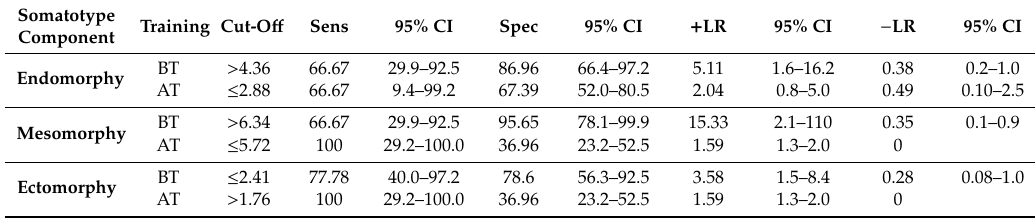
Table 5. Sensitivity. specificity and likelihood ratios of somatotype components in the beginner and advanced training groups.